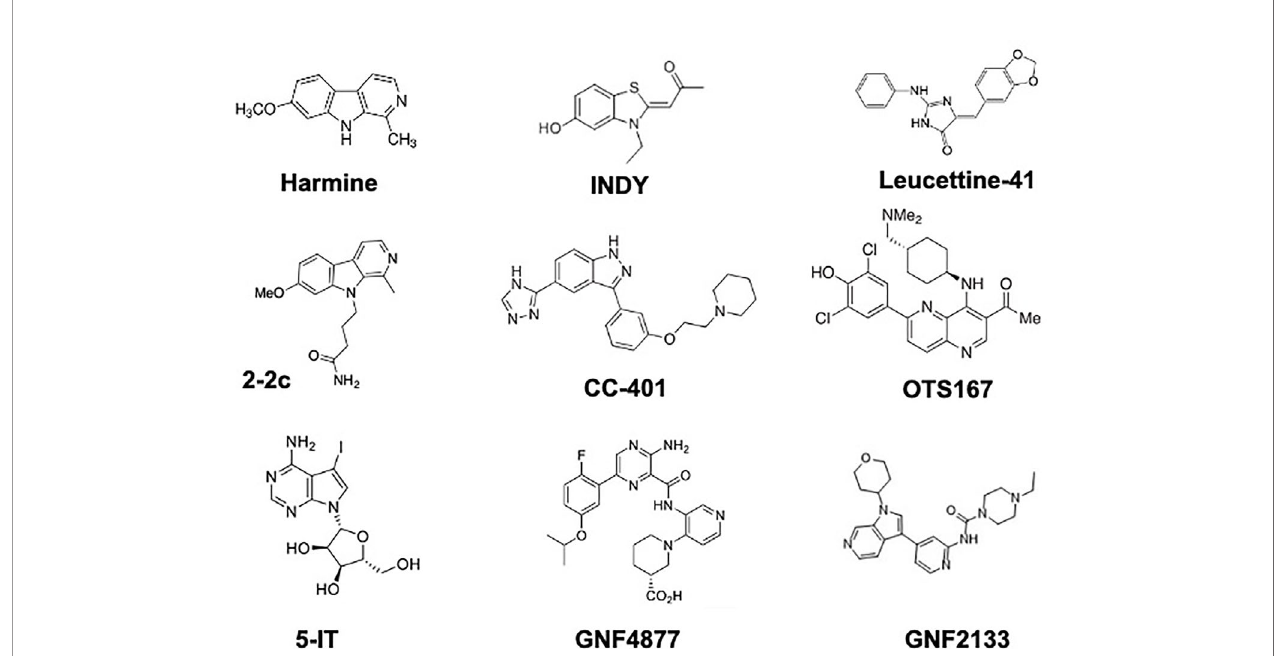
FIGURE 3 | Chemical Structures of DYRK1A Inhibitors That Have Been Demonstrated to Induce Human Beta Cell Proliferation. See text for details and